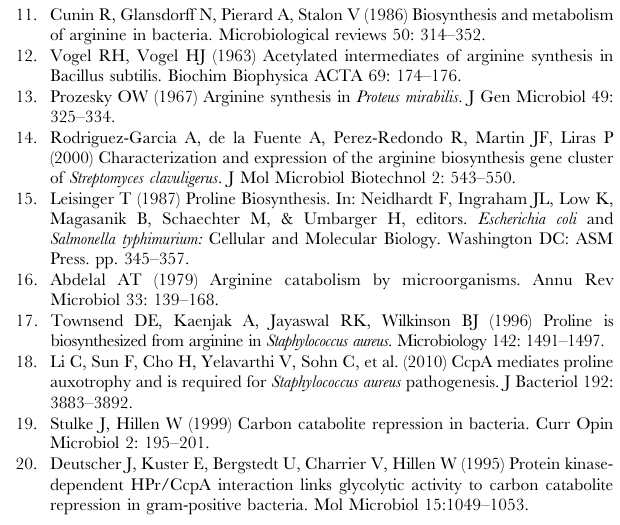
Table S1 Bacterial Strains and Plasmids used in study. Table S2 Oligonucleotides used in